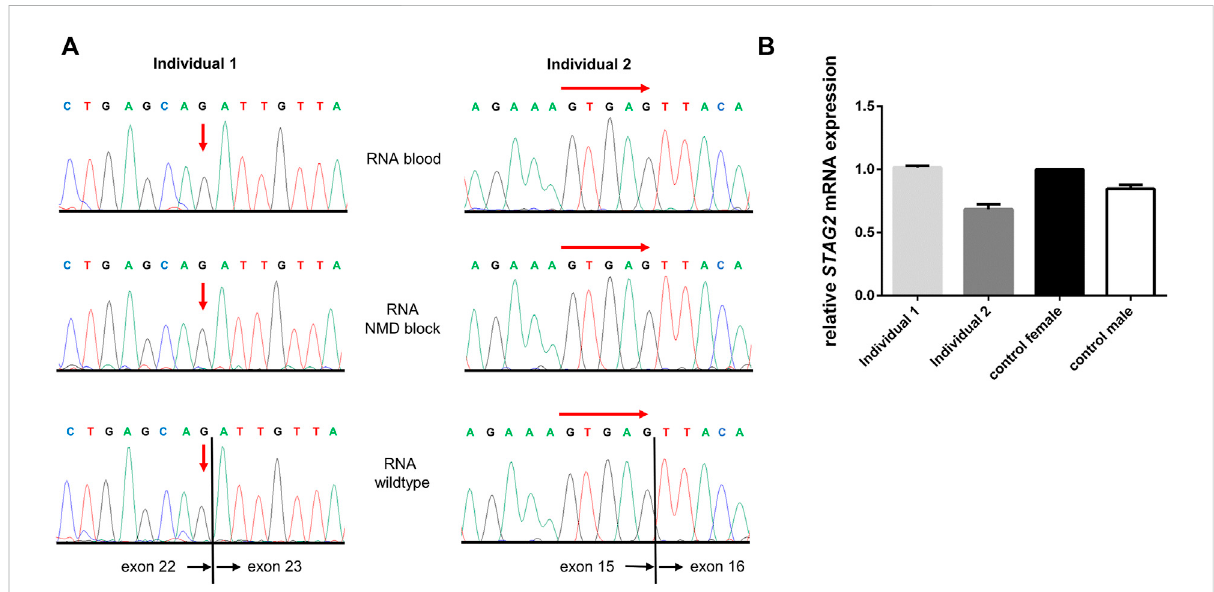
FIGURE 4 STAG2 RNAsequencing and expression analyses. (A) Sequencing of STAG2 transcripts for both individuals showed only wildtype sequences for the according regions. To block nonsense-mediated decay (NMD) lymphocytes from both individuals were treated with puromycin for 4 h and subsequently transcript analysis was performed. Again, no mutated or aberrantly spliced transcript was detected (middle panel). Red arrows indicate the locations of the expected variant (individual 1) or start of the expected deletion (individual 2). (B) Quantitative RT-PCR was performed for both individuals on RNA from blood, and relative STAG2 expression of a healthy female control was set to 100% (black bar). Relative STAG2 expressionofindividual2showedareductionof STAG2 expressiontoapp.60%(darkgreybar).Inindividual1theexpressionof STAG2 wasnot reduced (light grey